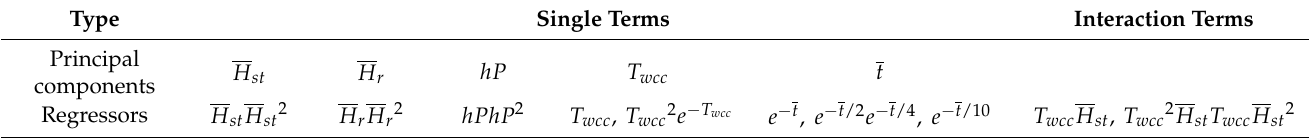
Table 5. Potential regressors for the water losses model.